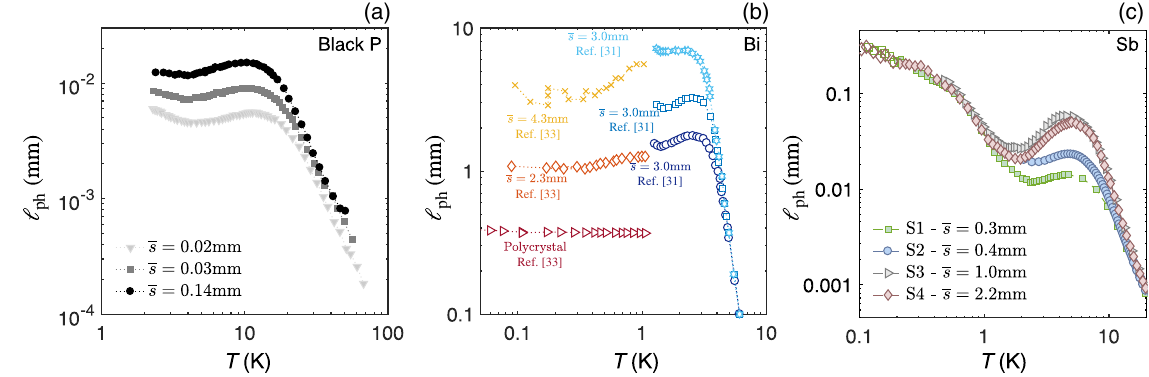
FIG. 3. The phonon mean-free path is short and intrinsic. The temperature dependence of the phonon mean-free path l phosphorus [10], (b) bismuth [31,33], and (c) antimony (this work) as a function of the temperature. Only in Sb l the sample size at low temperature and remains well below the sample